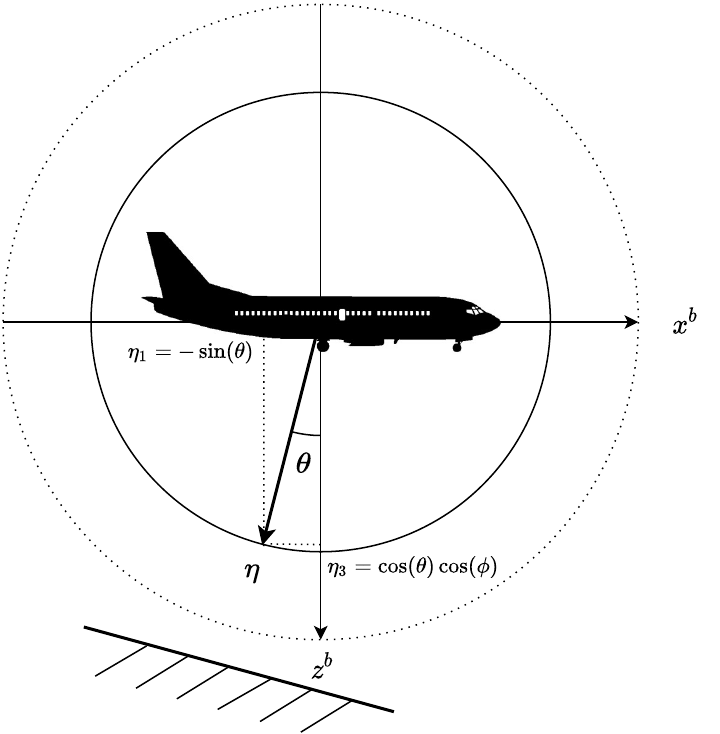
Figure 3. Reduced-attitude representation. The aircraft is shown from the side, illustrated with a section of the two-sphere possibly with a non-zero roll